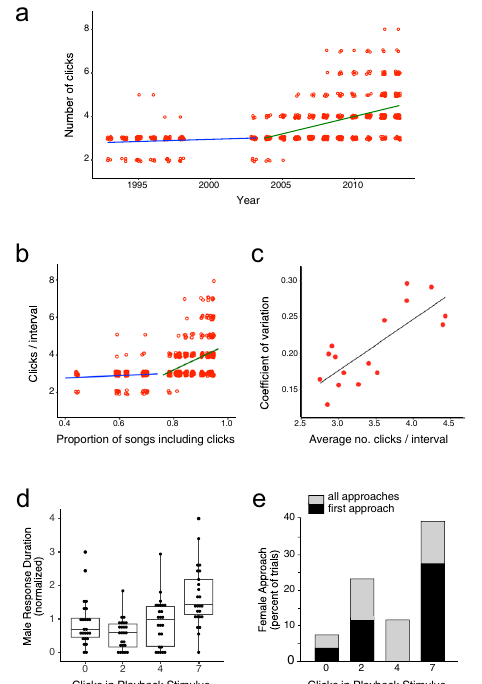
Fig. 3 Cumulative changes to click trains and responses to playbacks of click trains. a The number of clicks in a train was stable until 2003 and increased thereafter. b The number of clicks in a train as a function of the proportion of the population ’ s songs that included click trains. The breakpoint (75%) corresponds to 2004; see text for details. c As the number of clicks in a train increased, so did the coef fi cient of variation. d Click trains with 7 clicks elicited longer-lasting aggressive responses from males ( n = 25) in playback experiments (the centre bar shows the median, boxes the 25th and 75th percentiles, and the whiskers the 95th percentile). e Females that responded ( n = 11) were more likely to approach click trains with 7 clicks (black portion of bars = female ’ s fi rst approach to the playback speaker; gray bars = approaches to the speaker in subsequent trials). Source data are provided in the Source Data fi